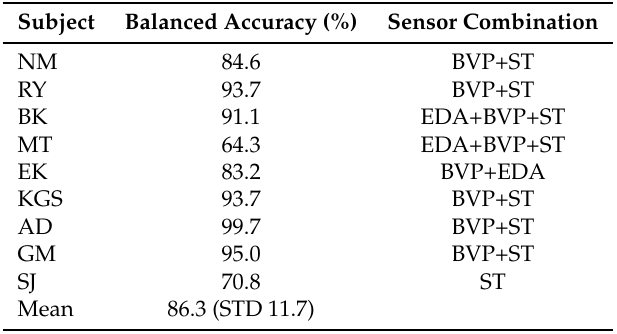
Table 6. Best subject-wise recognition rates obtained using user-independent regression model, and which sensor combination was used to obtain this